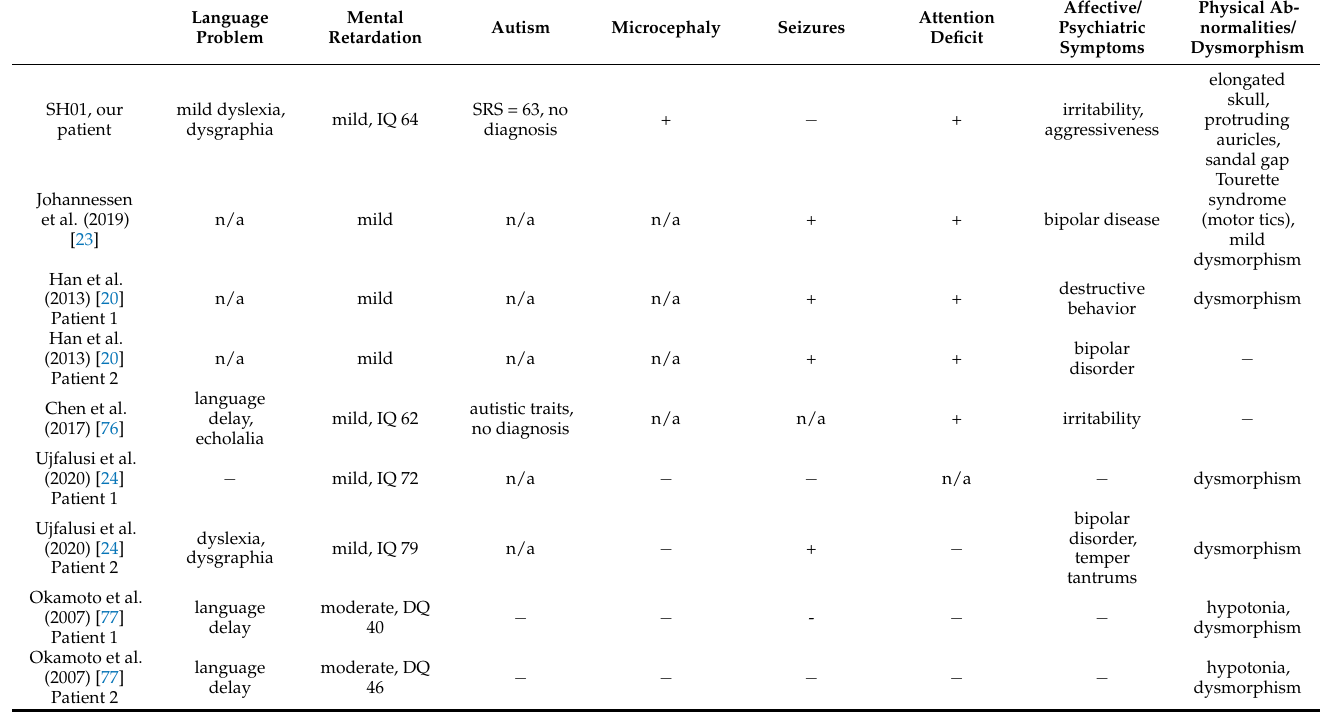
Table 2. Clinical phenotype of patients with 22q13.3 duplication and 22q13.3 deletion/mutations. In addition to individual cases of patients with 22q13.3 duplication (that include SHANK3 gene), the last two lines show the overall occurrence (in percentage) of the symptoms in patients with 22q13.3 duplication (based on [21] and our own review of individual cases reported previously) and 22q13.3 deletion/mutations (taken from previous reviews). Our subject, SH01, is also included for comparison. As patients of different ages are described, both IQ and developmental quotient (DQ) are used to characterize mental retardation. +/ − reflects the presence/absence of the